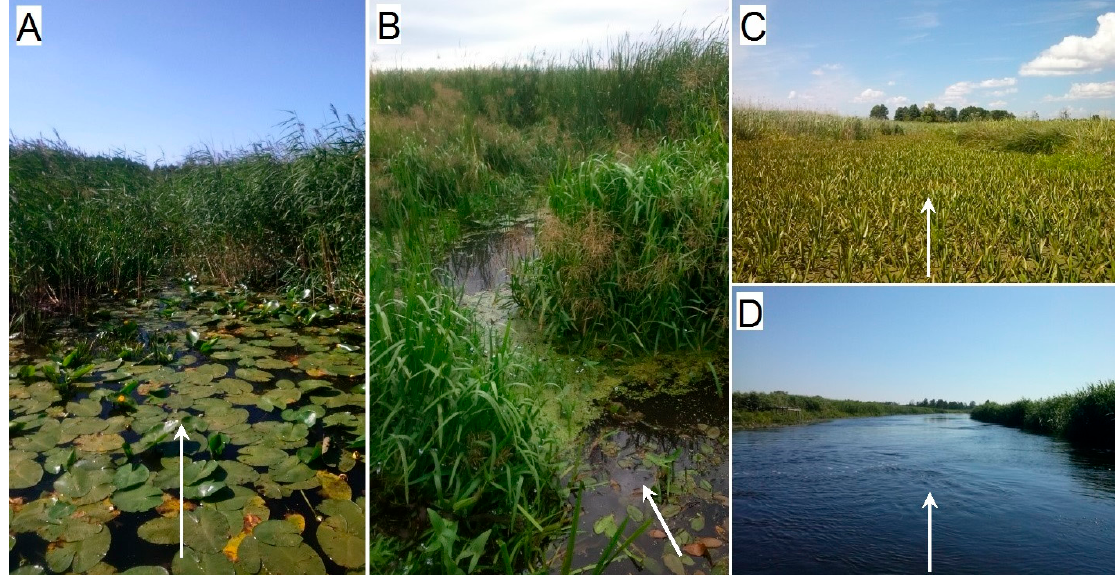
Figure 4. In-stream vegetation presence/absence during summer season in: ( A ) Reach 6; ( B ) Reach 8; ( C ) Reach 9; and ( D ) Reach 19. White arrows indicate the direction of flow.